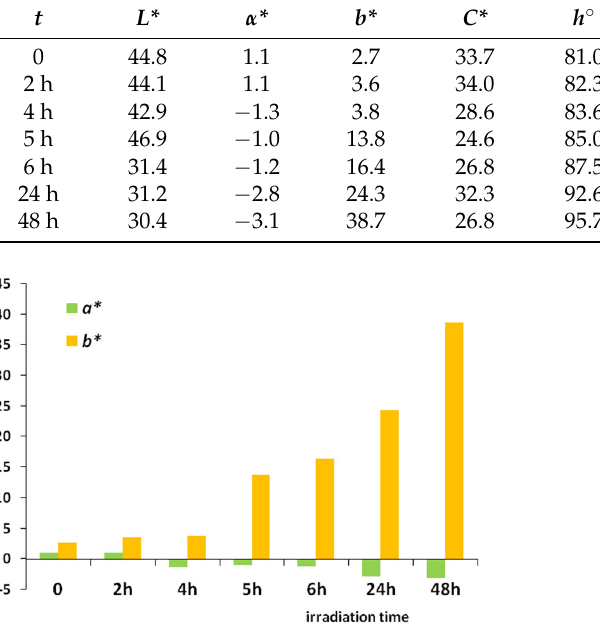
Figure 5. Infrared spectra of polycyanoacrylate film after UV exposure for t = 1, 6, and 24 h. Table 2. Recordings and estimations of colorimetric parameters over several UV irradiation time intervals.